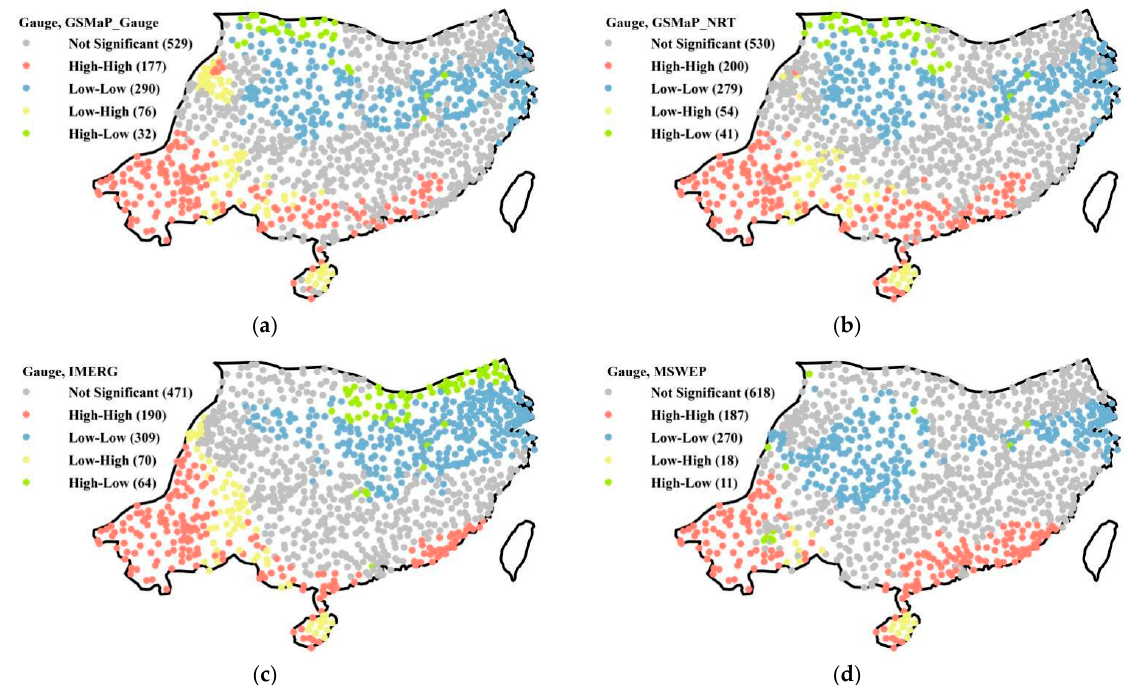
Figure 19. The LISA cluster maps of CDD between the gauge observations and the four SPPs in SC: ( a ) GSMaP_Gauge, ( b ) GSMaP_NRT, ( c ) IMERG and ( d ) MSWEP.